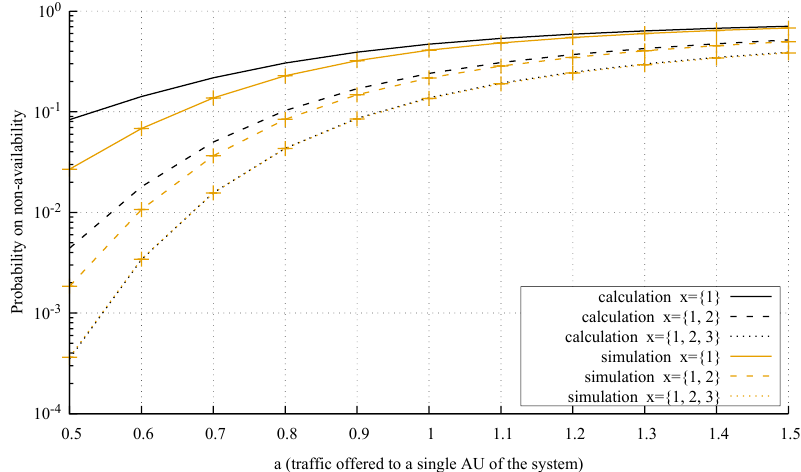
Figure 2. Probability of the non-availability of x strictly determined resources for class 2 calls ( t 2 = 2) in System 1, where x is the set of strictly determined resources in the limited-availability group.